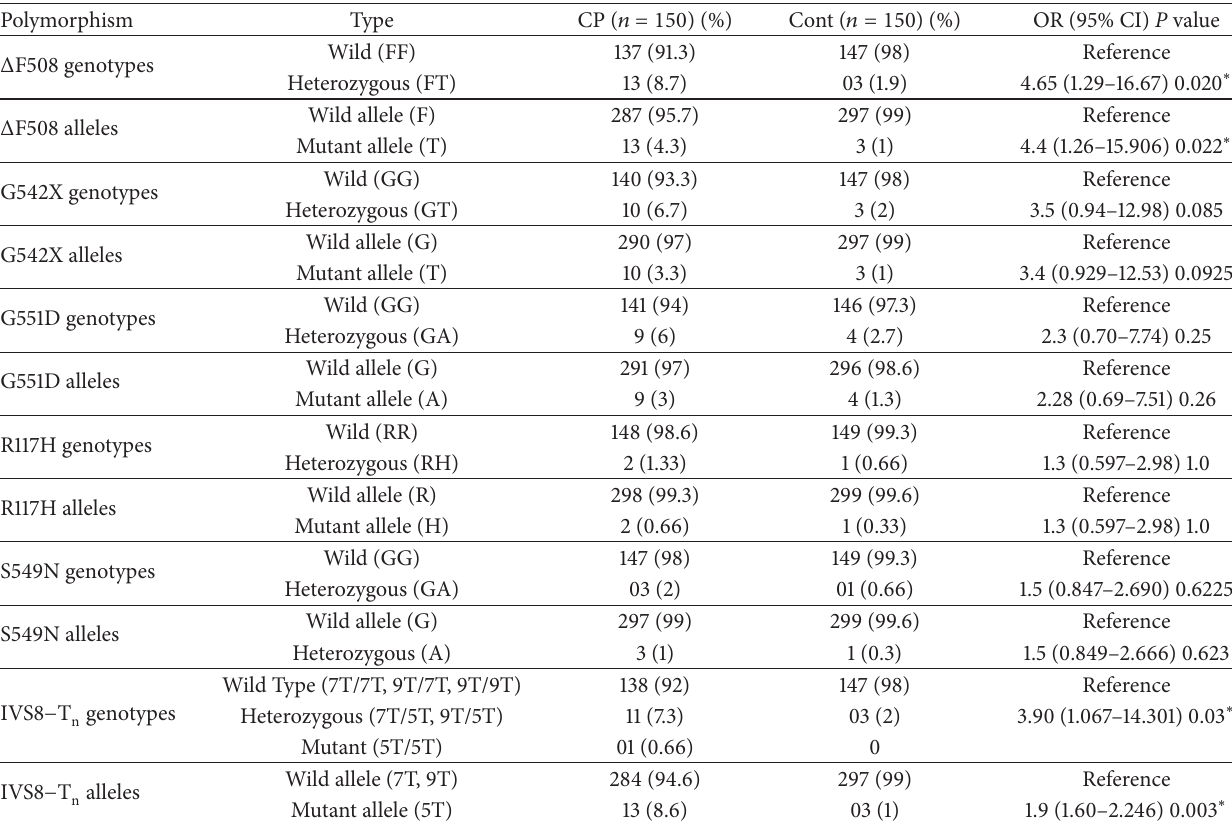
Table 3: Genotype and allele frequency of CFTR gene.